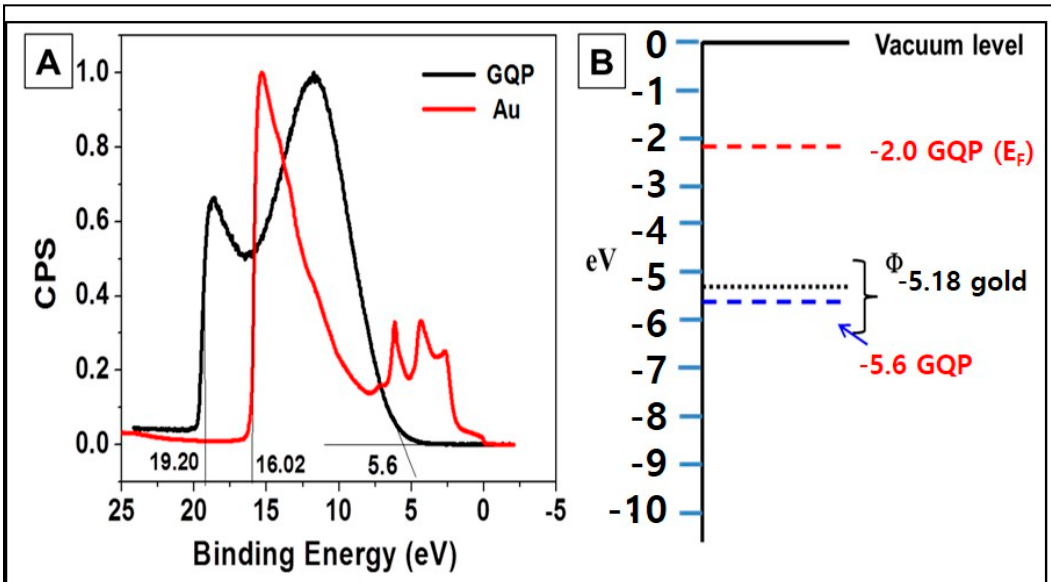
Figure 5. ( A ) Ultraviolet photoelectron spectroscopy (UPS) spectra ( B ) Fermi energy, a work function of GQPs (taking gold as